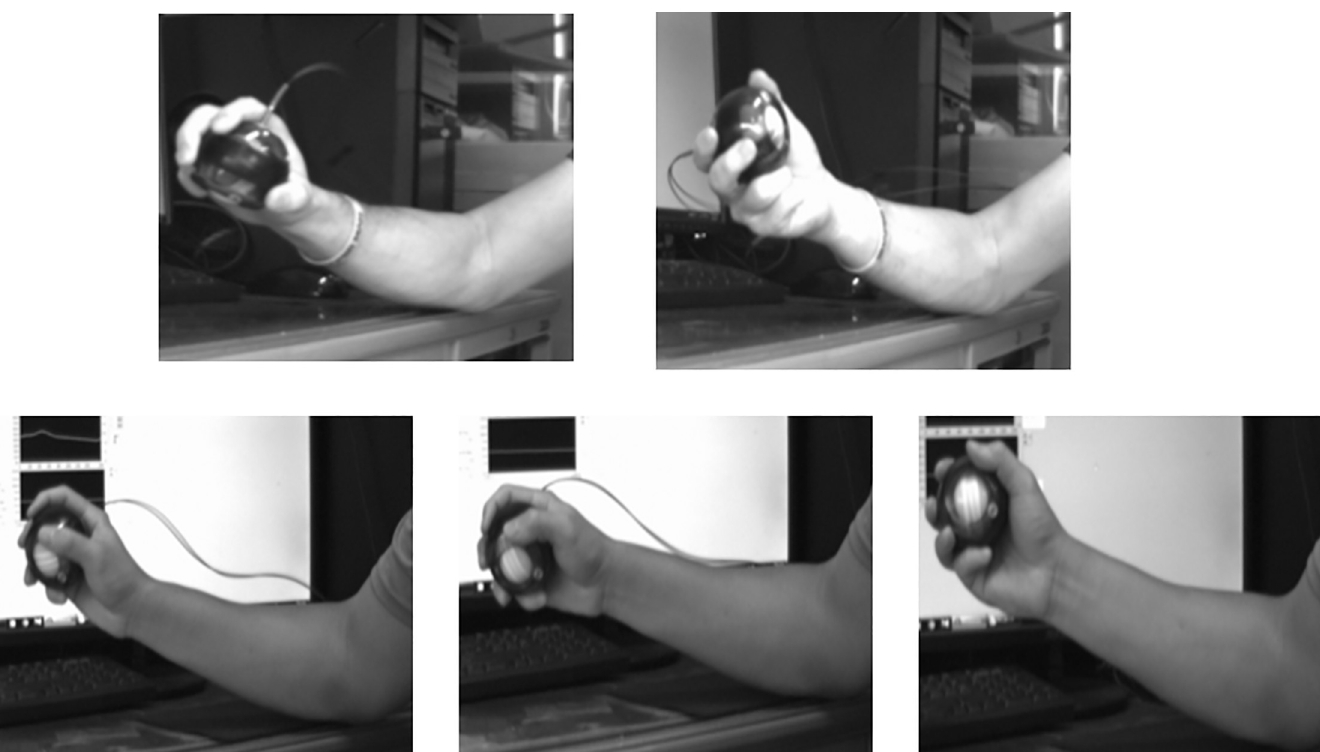
Fig 8. Two basic roller ball movement patterns observed from the experiment. The top 2 pictures show the pattern of pronation-supination of the proximal radio- ulnar joint only; the bottom 3 pictures depict the movement pattern composed of proximal radio-ulnar joint and the wrist rotation movement. The bottom pattern was observed rotating in both clockwise and counterclockwise